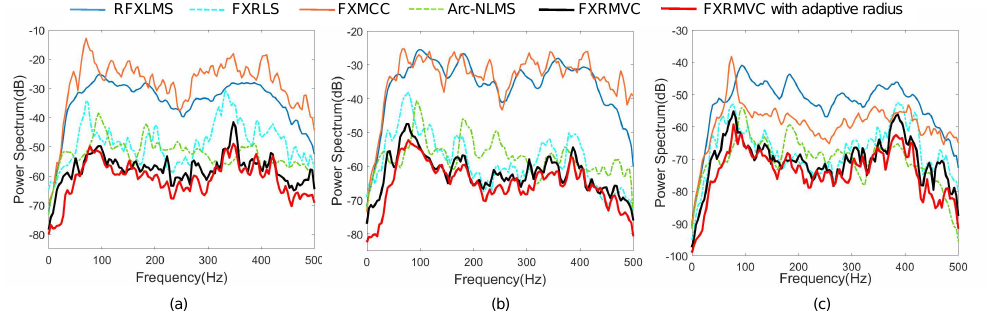
Figure 8. PSD level comparison under different impulse noise cases: ( a ) α = 1.2, ( b ) α = 1.4 and ( c ) α =